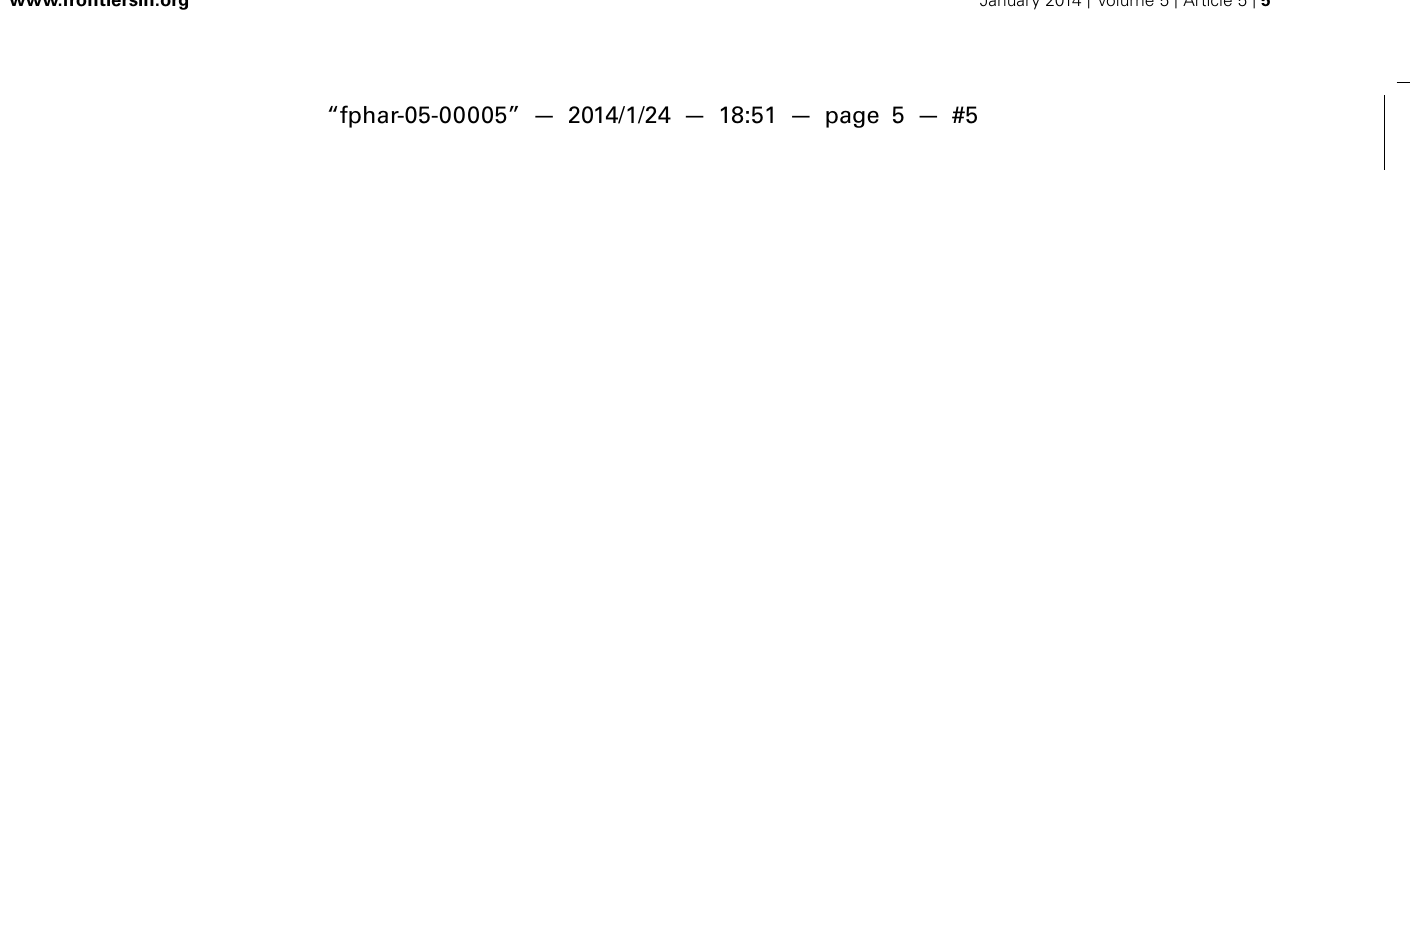
negative effect of acidosis on contractile proteins and supply the substrate for the slow mechanical recovery during acidosis. (B) . Putative intracellular mechanisms of post-acidosis induced-arrhythmias. Upon returning to control pH, the inhibitory effects of acidosis are rapidly removed, favoring the increase in Ca 2 + cycling and the contractile recovery towards control levels. However, the relief of RyR2 from the previous constrain produced by acidosis, evokes also an increase in diastolic Ca 2 + leak from the (Ca 2 + -loaded) SR. Such release may activate inward currents through the NCX, also relieved from the inhibition evoked by acidosis.The inward Na + current, if large enough, can trigger